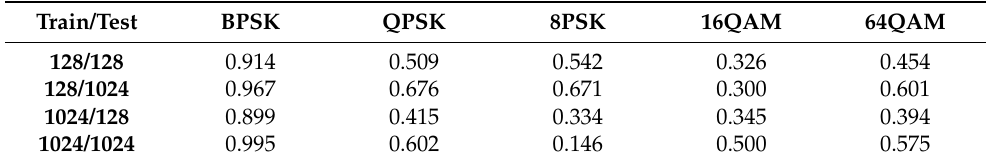
Table 3. F 1 score on different sequences for biased